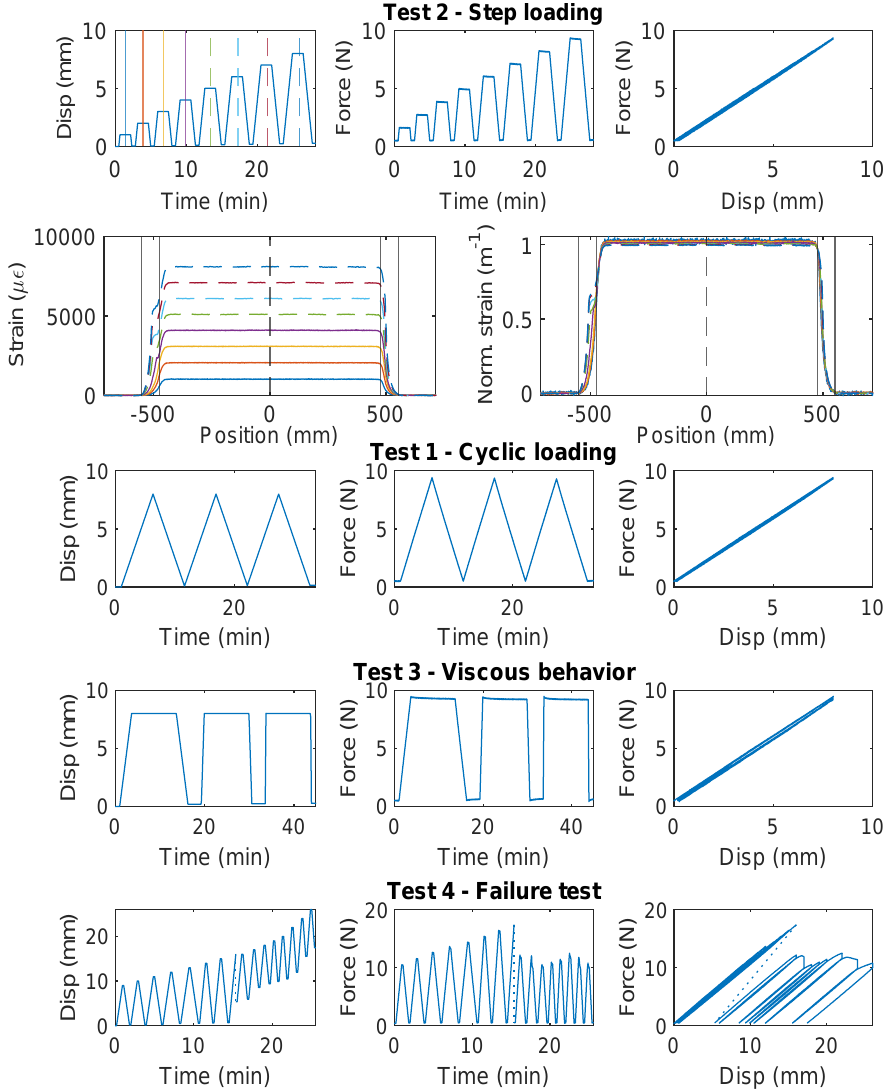
Figure 5. The loading protocol, force–displacement relation and strain distributions under increasing displacement levels (represented by different color lines) for Specimen 3 of the PAI 0.9 mm cable. The strain distributions for the selected specimens of PAI 0.9 mm and PUR-PAI 2.0 mm under increasing displacement demand are presented in Figures 5 and 6, respectively. The strain distributions are taken from the displacement levels indicated by the vertical lines in the upper-left Disp–Time graph, with the corresponding color and line type.